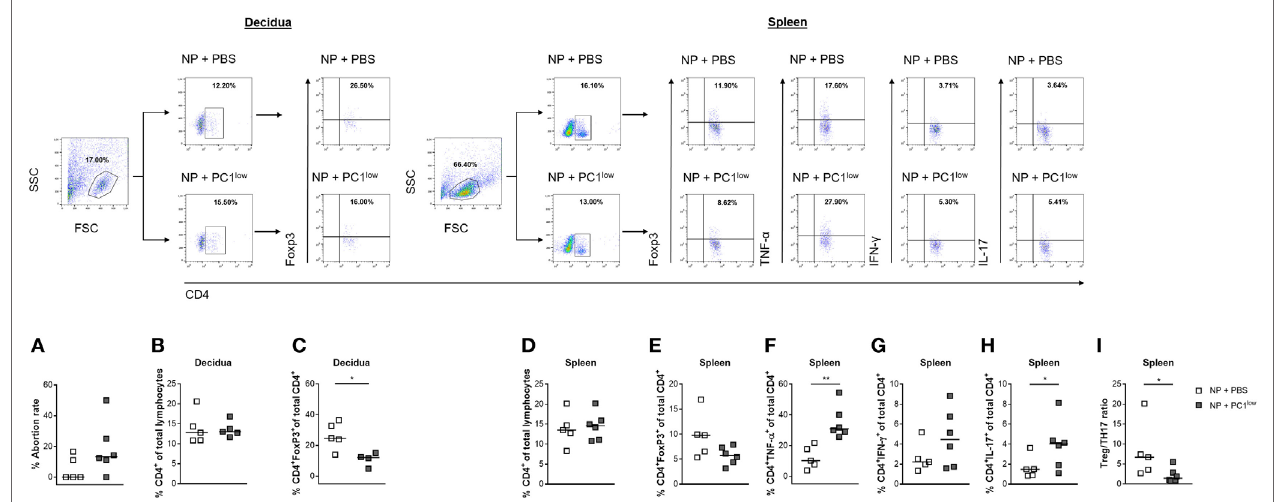
FigUre 4 | Adoptive transfer of PC1 low B1a B cells to NP females resulted in an increased fetal rejection rate and significantly reduced the splenic regulatory T (Treg)/TH17 ratio. 1 × 10 5 peritoneal sort-purified PC1 low B1a B cells from NP females [gestation days (gds) 13–14] were adoptively transferred into NP females ( n = 6) on gd7–9. Control females ( n = 5) received PBS. The recipients were sacrificed on gd12, and the abortion rate (a) was determined. Moreover, CD4 + T cell (B) and CD4 + Foxp3 + Treg frequencies (c) were assessed in decidual tissue. In spleen, the frequencies of CD4 + T cells (D) , CD4 + Foxp3 + Treg cells (e) , CD4 + TNF- α + (F) , and CD4 + IFN- γ + (g) TH1 cells as well as the frequencies of CD4 + IL-17 + TH17 (h) cells and the Treg/Th17 ratio (i) were determined. Flow cytometry gating strategy and representative dot plots are included in this figure. Graphical data are displayed as medians. Each symbol represents a single animal, and the presented number of mice refers to pooled data of two independent experiments. Statistical analysis was performed using the non-parametric Mann– Whitney- U test (* p ≤ 0.05 and ** p ≤ 0.01). Abbreviation: NP, normal